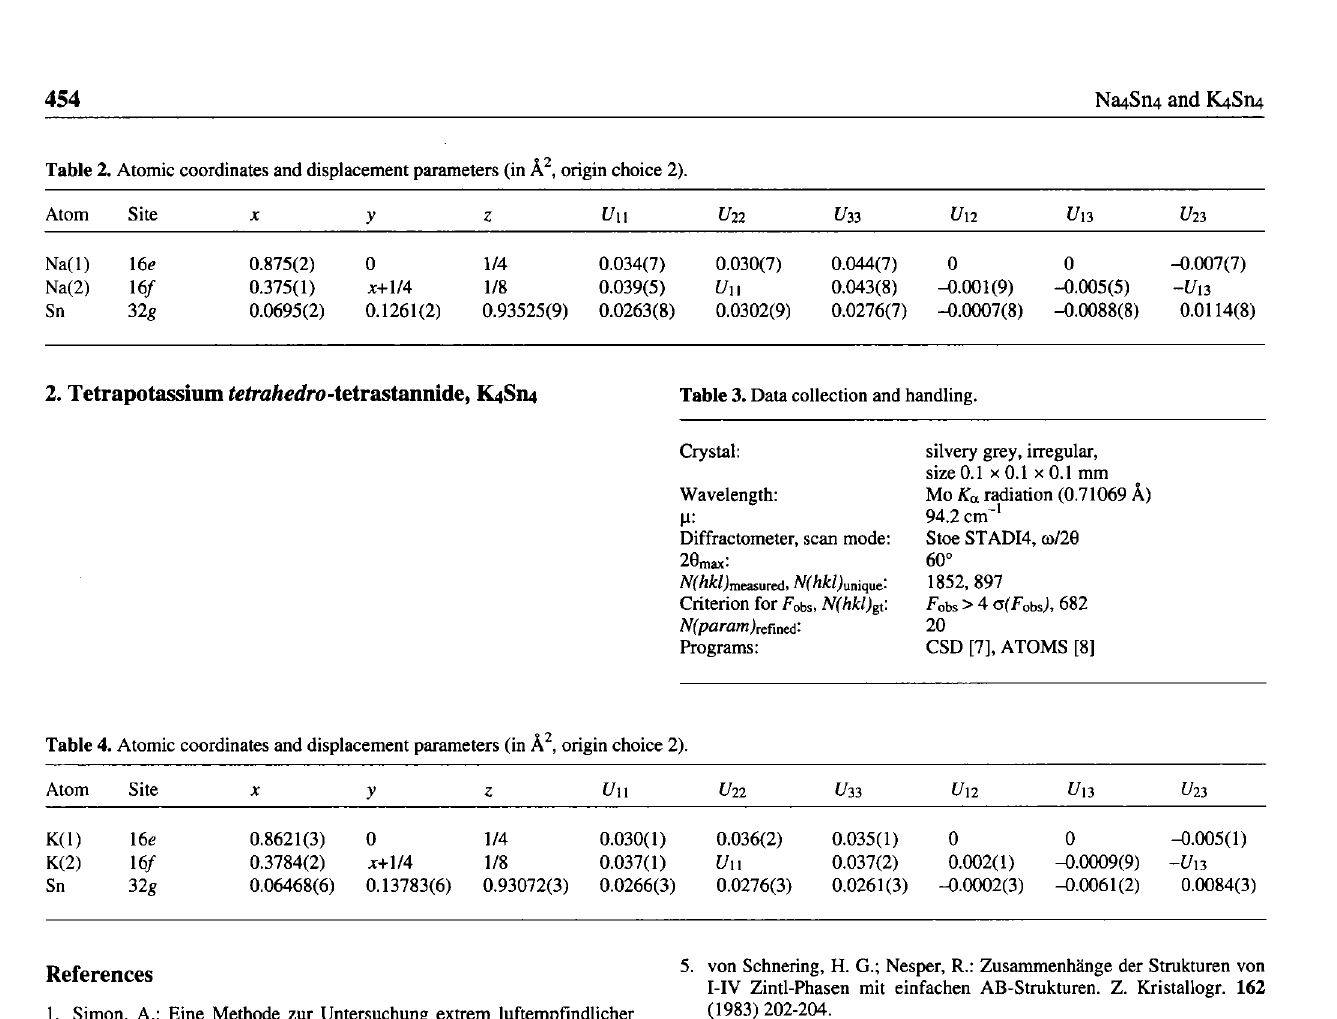
Table 3. Data collection and handling.